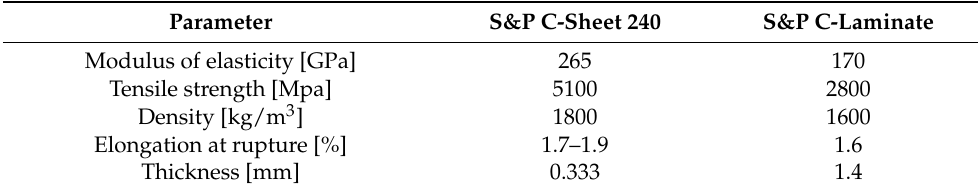
Table 2. Mechanical and physical parameters of composite reinforcement (exposed by manufac- turer)